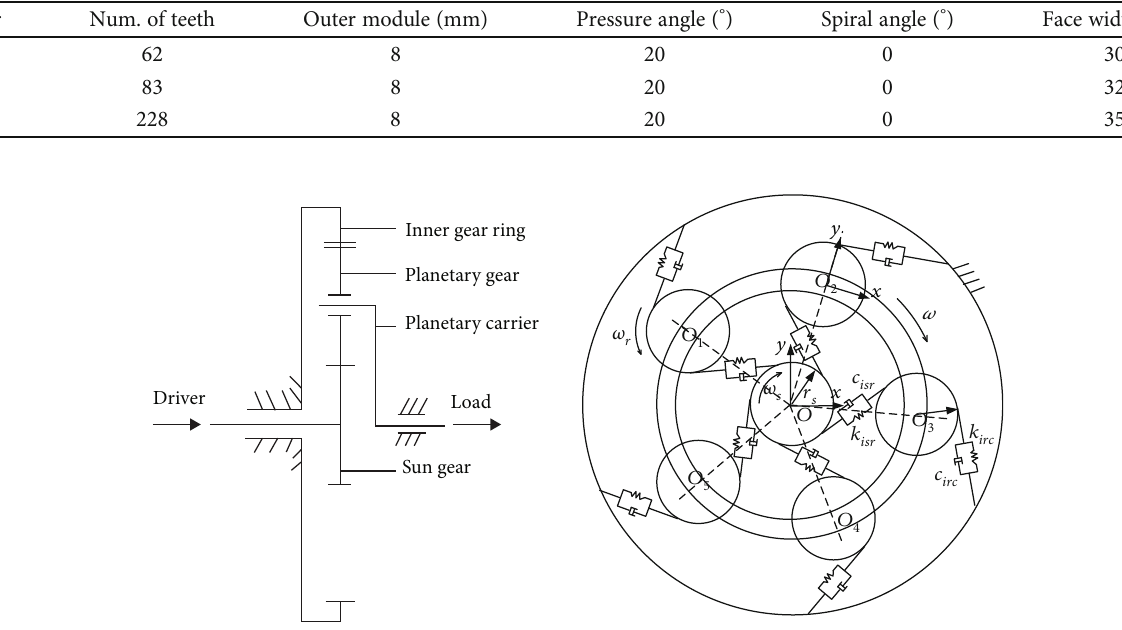
Table 1: Gear parameters of the study planetary gear trains.